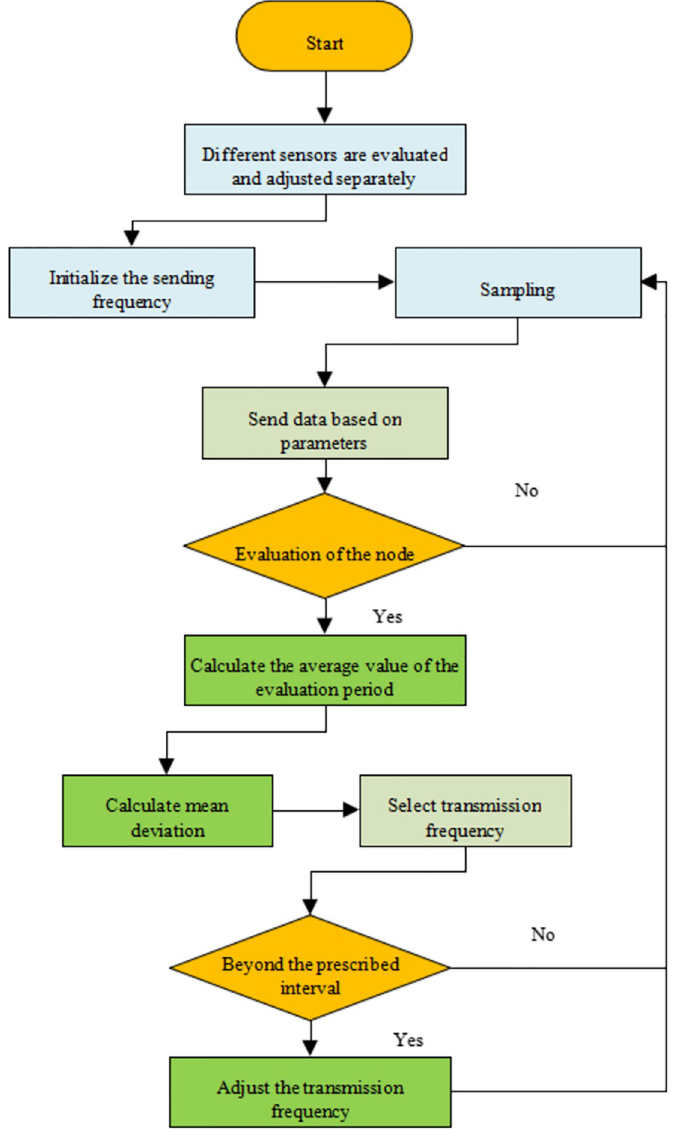
Fig 4. Flow of the deviation detection